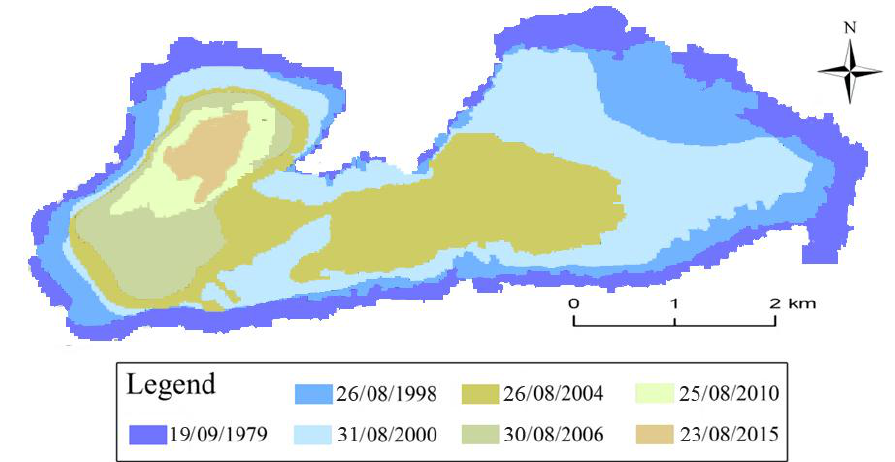
Figure 4. Variations in the spatial distribution range of Bojiang Lake during different typical periods.